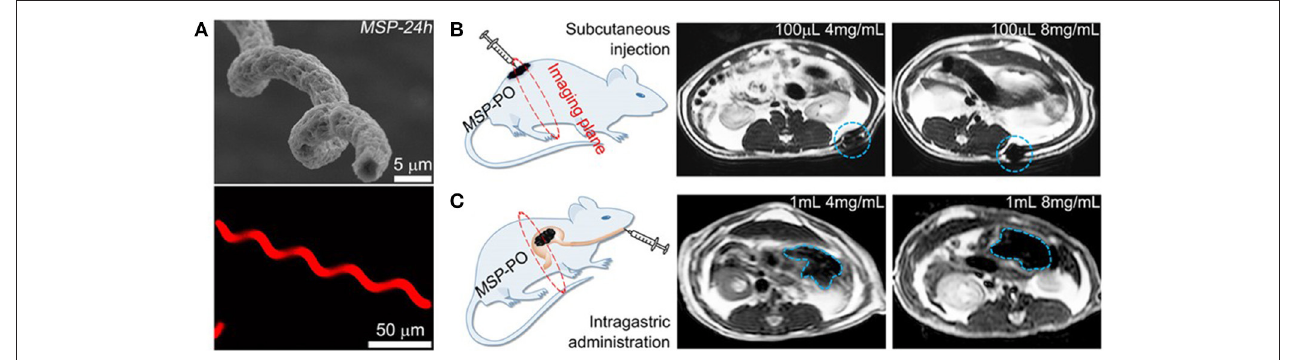
FIGURE 5 | In vivo imaging of magnetically propelled microrobot. (A) Scanning electron microscopy (SEM) ( top ) and fluorescence images ( bottom ) of the helical structured microrobot. Schematic of the target in vivo area and magnetic resonance imaging of microrobots inside rats. Illustrating different microrobot concentrations at the (B) subcutaneous tissues and (C) inside the mouse stomach. Reprinted with permission from Yan et al. (2017). Copyright 2017 The American Association for the Advancement of